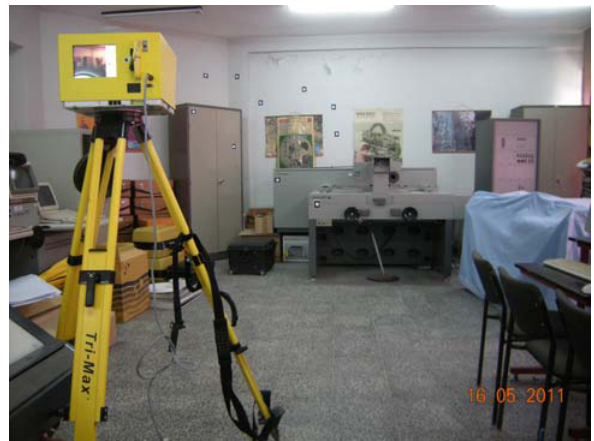
Figure 3. SIFT Keypoints with scale and rotations. 2121